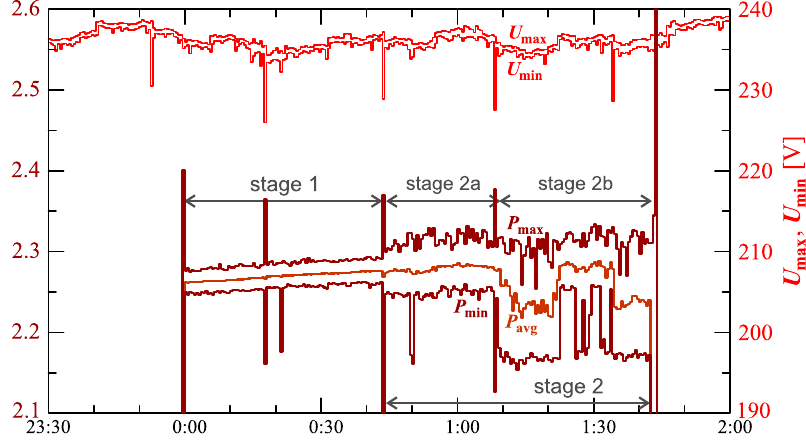
Figure 5. The characteristics of maximum P max = f ( t ) , average P avg = f ( t ) , and minimum P min = f ( t ) values of active power and maximum U max = f ( t ) and minimum U min = f ( t ) rms values of the supply voltage for Case